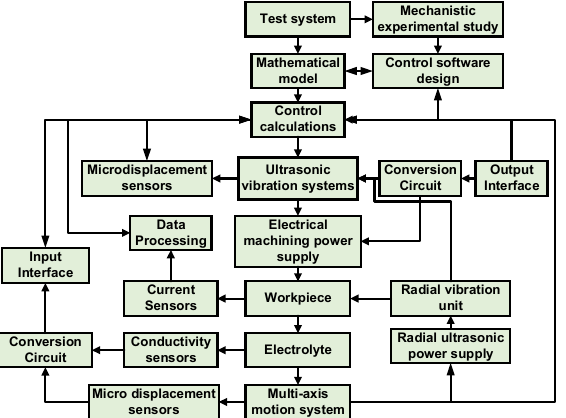
Figure 4. Schematic of the control system.